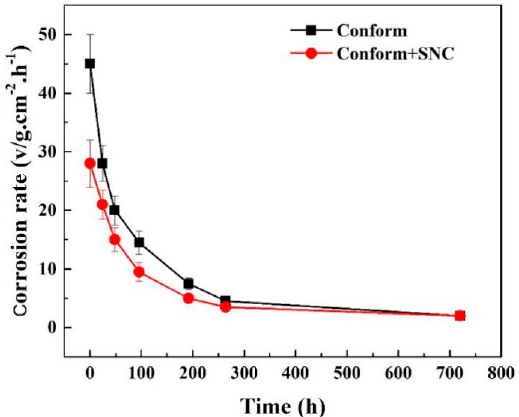
Figure 6. Corrosion rates (with duration) of conform and conform + SNC Cu-Mg alloy immersed in 0.1 M NaCl solutions at different times.